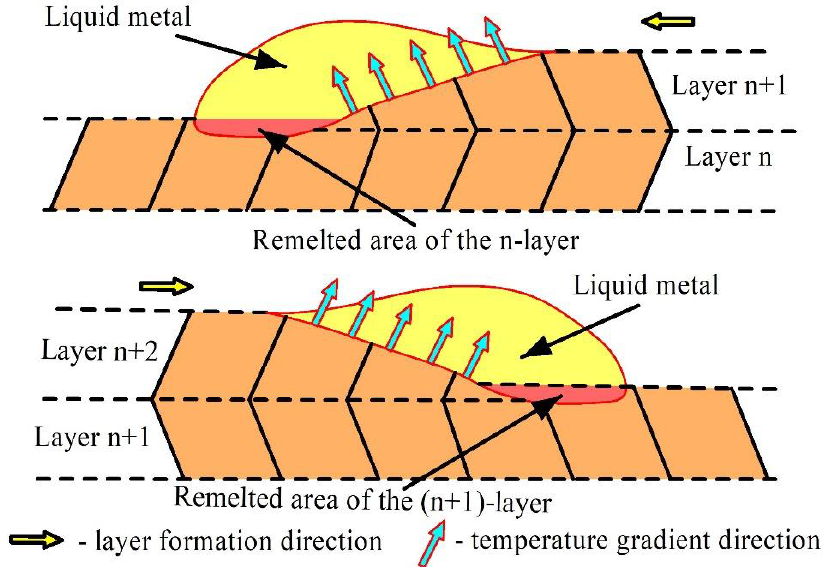
Figure 19. The zigzagged columnar grain structure formation. Along with columnar grains, the third type microstructures contained layers of small almost equiaxed grains with high-angle and annealing twin boundaries that were formed due to low heat input and fast solidification of the first metal portions transferred